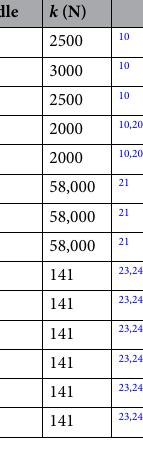
Table 1. Stiffness parameters (expressed as force per unit strain) for each ligament